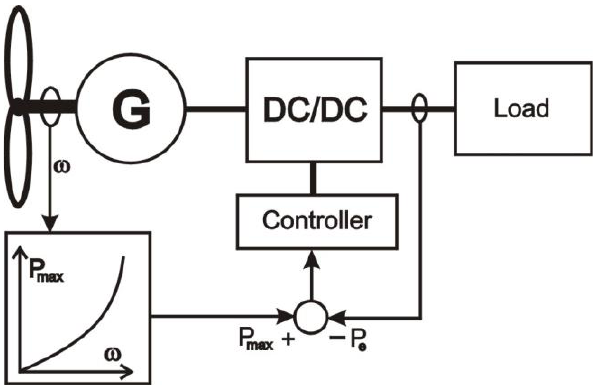
Figure 5. Power signal feedback control.